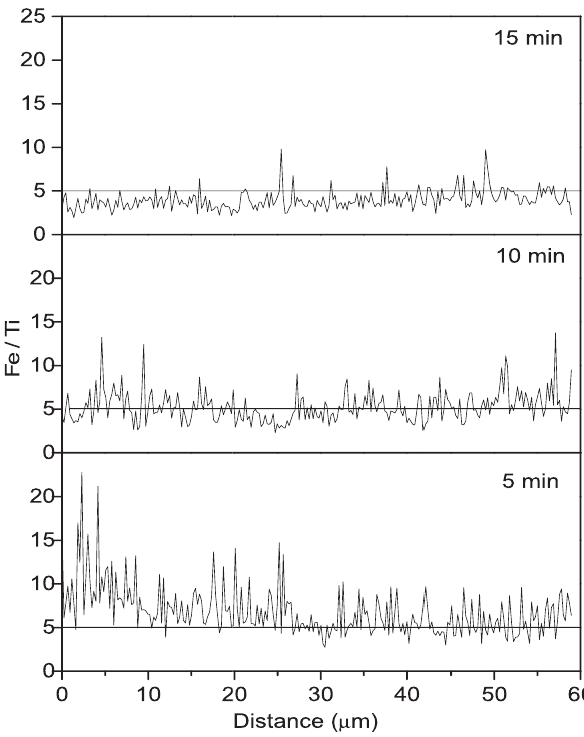
Figure 13: The Fe/Ti ratios of the white phase in HCVTM pellet roasted at 1,573 K for 5 min, 10 min, and 15 min.